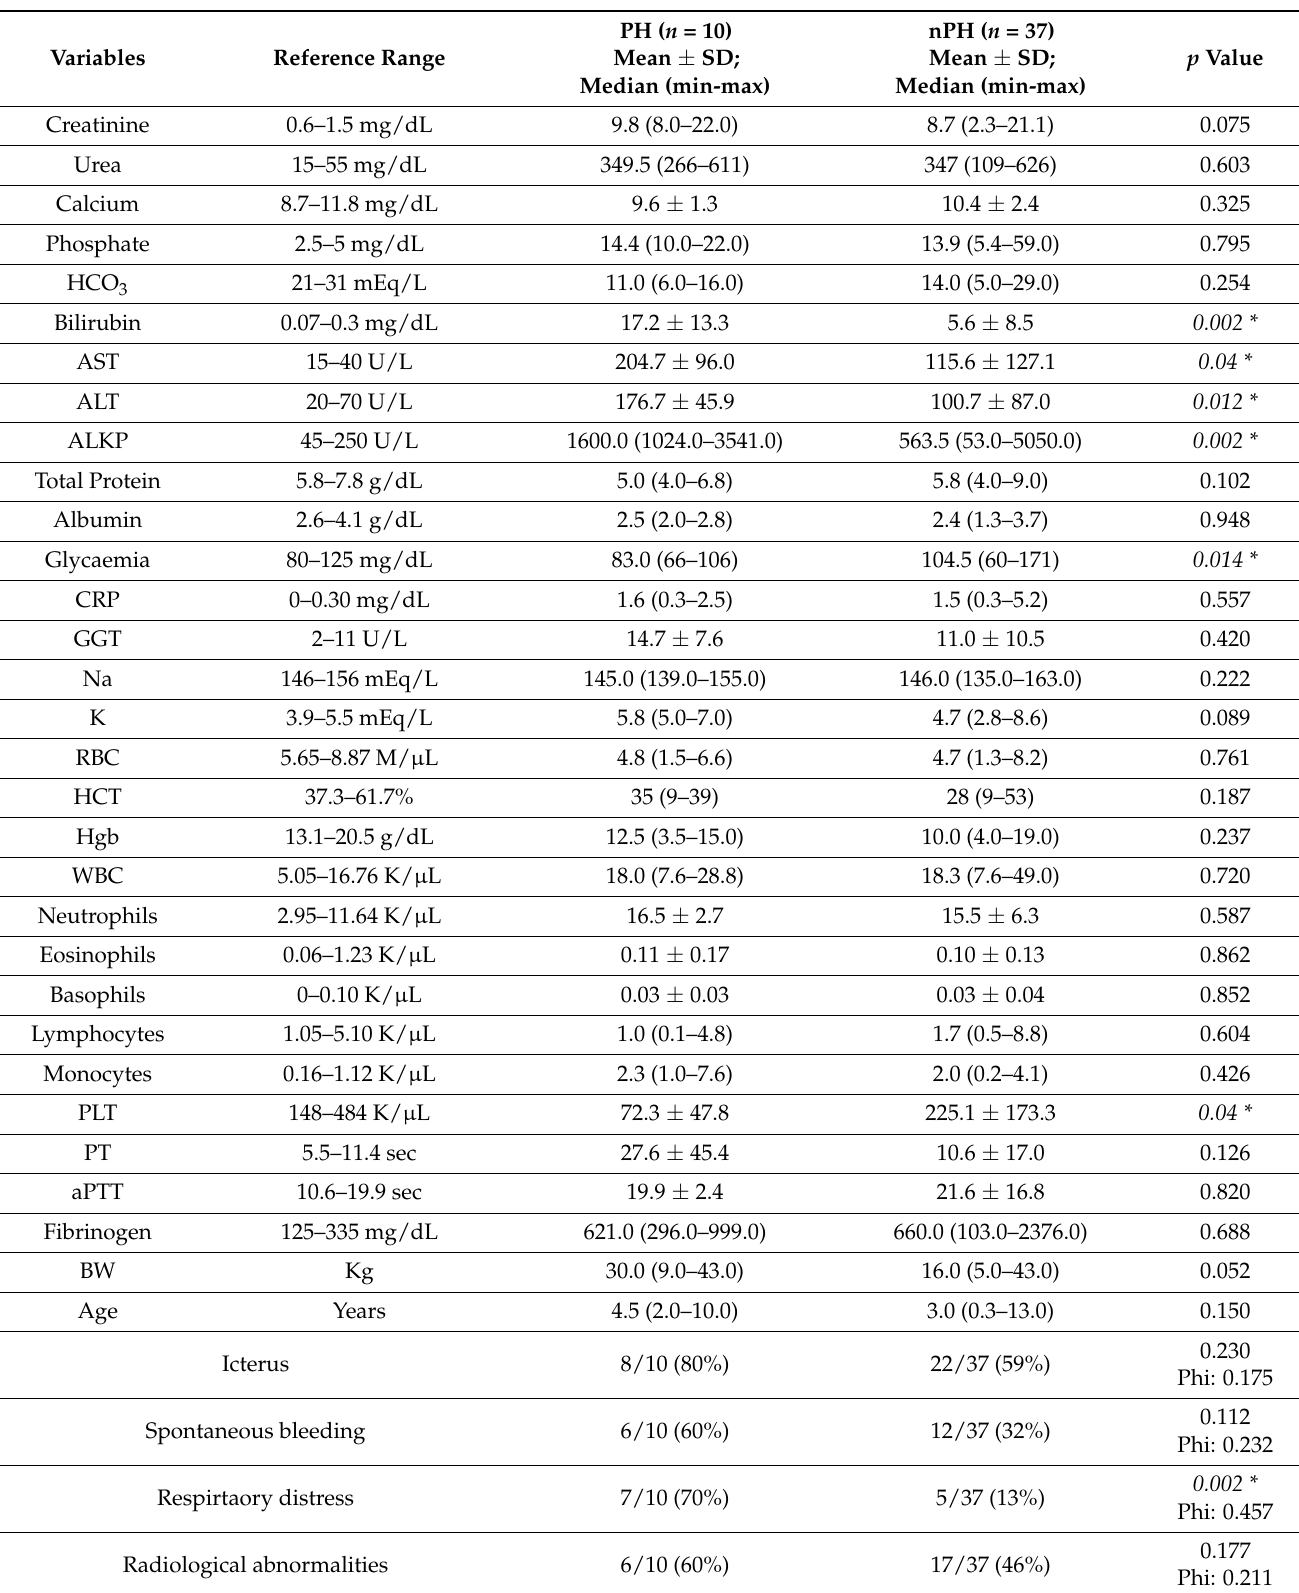
Table 1. Statistical comparison of laboratory, clinical and radiographic variables at hospital admission, between the two study